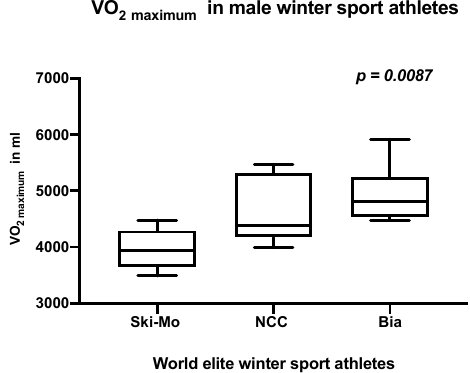
Figure 4. Analysis of maximum ventilatory oxygen uptake (VO 2 maximum ) in male world elite winter sport professionals ( p = 0.0087).